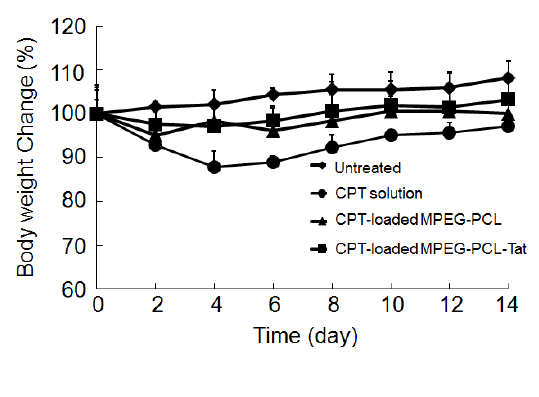
Figure 4. Body weight change in the two weeks after in rats bearing intracranial C6 glioma after no treatment (diamonds) or treatment with intranasal camptothecin (CPT) solution (circles), CPT-loaded MPEG-PCL (triangles) or CPT MPEG-PCL-Tat